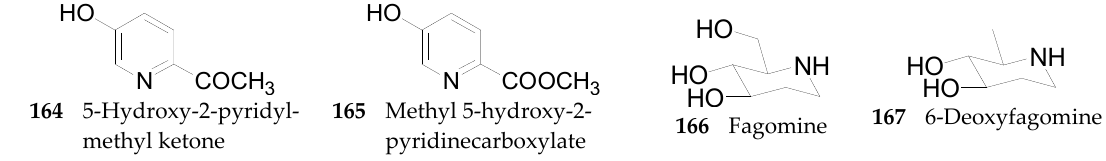
Figure 11. Chemical structures of compounds 164 – 167 .